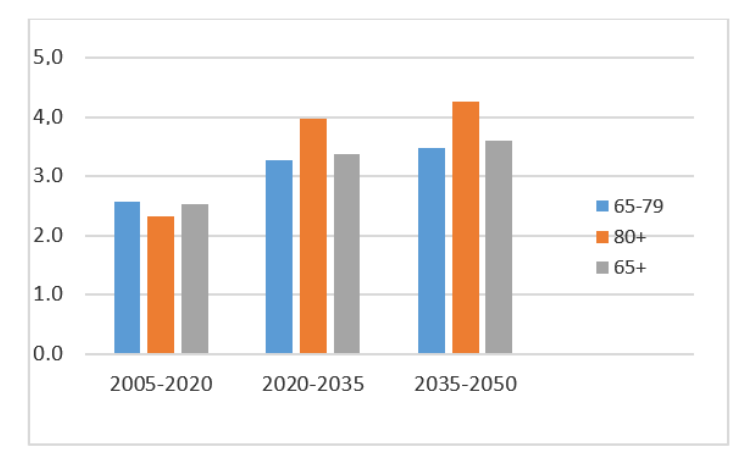
Figure 1 – Average annual increment rate (%) of population 65 and over by age classes. Egypt 2005–2050. Note: The average annual growth rates for all of the age classes considered here are calculated on the assumption that growth is continuous. Source: our elaborations of data from United Nations